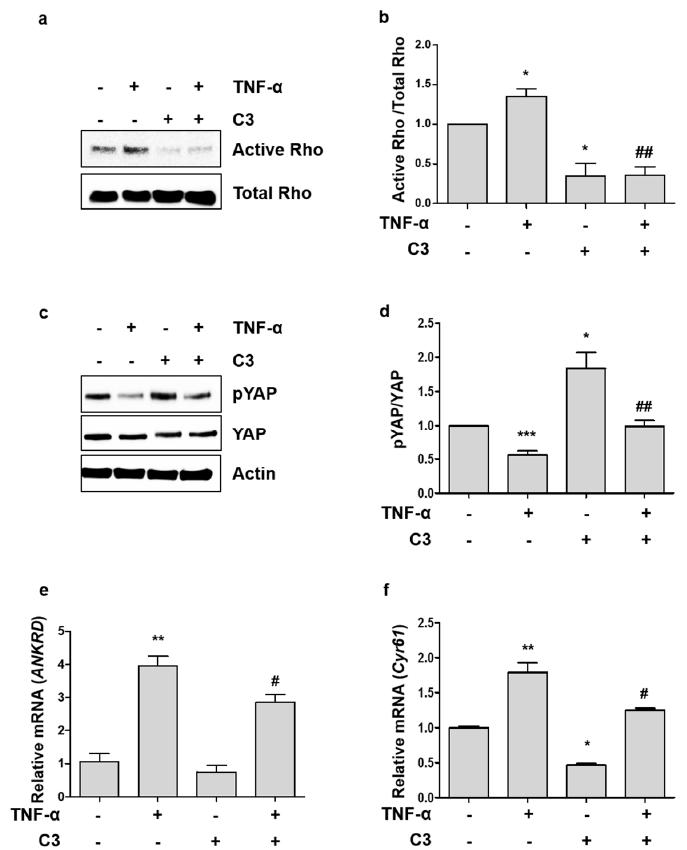
Figure 2. TNF- α -induced YAP dephosphorylation and activation is dependent on Rho GTPases. ( a ) HUVECs were pretreated with C3 transferase for 4 h and then treated with TNF- α for 5 min. Active and total forms of Rho GTPases were detected by immunoblotting. ( b ) Ratio of active to total Rho GTPase was quantified. ( c ) HUVECs were treated with TNF- α for 6 h in the absence or presence of C3 transferase. Whole cell lysates were analyzed by immunoblotting with anti-pYAP (S127), anti-YAP, and anti- β -actin antibodies. ( d ) YAP phosphorylation was quantified. ( e , f ) HUVECs were treated with TNF- α for 6 h in the presence or absence of C3 transferase, and the mRNA levels of ANKRD and CYR61 were measured by qRT-PCR. Data are presented as the mean ± S.E. ( n = 3 independent experiments). *** p < 0.001, ** p < 0.01, and * p < 0.05 vs. untreated control and ## p < 0.01, and # p < 0.05 vs. TNF- α treated cells.